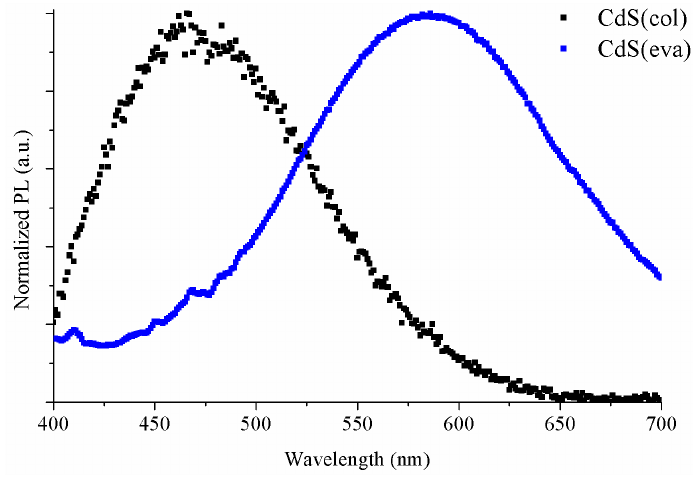
Figure 6. CdS(col) and CdS(eva) NCs normalized PL spectra.